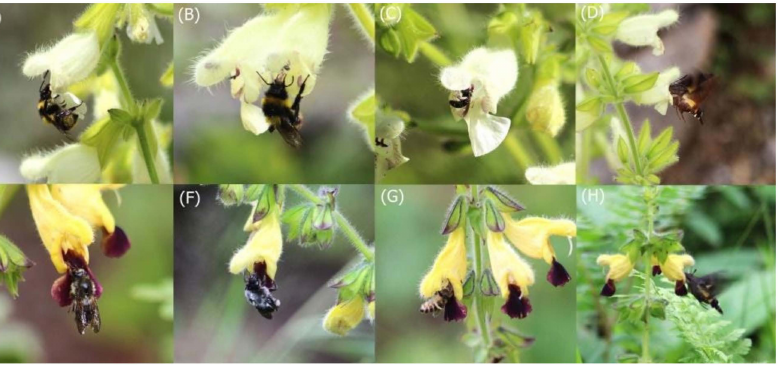
Figure 4. Flowering individuals of Salvia digitaloides (from ( A – D )) and S . flava (from ( E – H )) and their pollinators. Bombus secures ( A ), B . friseanus ( B ), Dufourea carbopila ( C ), and Macroglossum pyrrhosticta ( D ) visiting flowers of S . digitaloides . B . remotus ( E ), B . funararius ( F ), Apis cerana ( G ), and Macroglossum nycteris ( H ) visiting flowers of S . flava